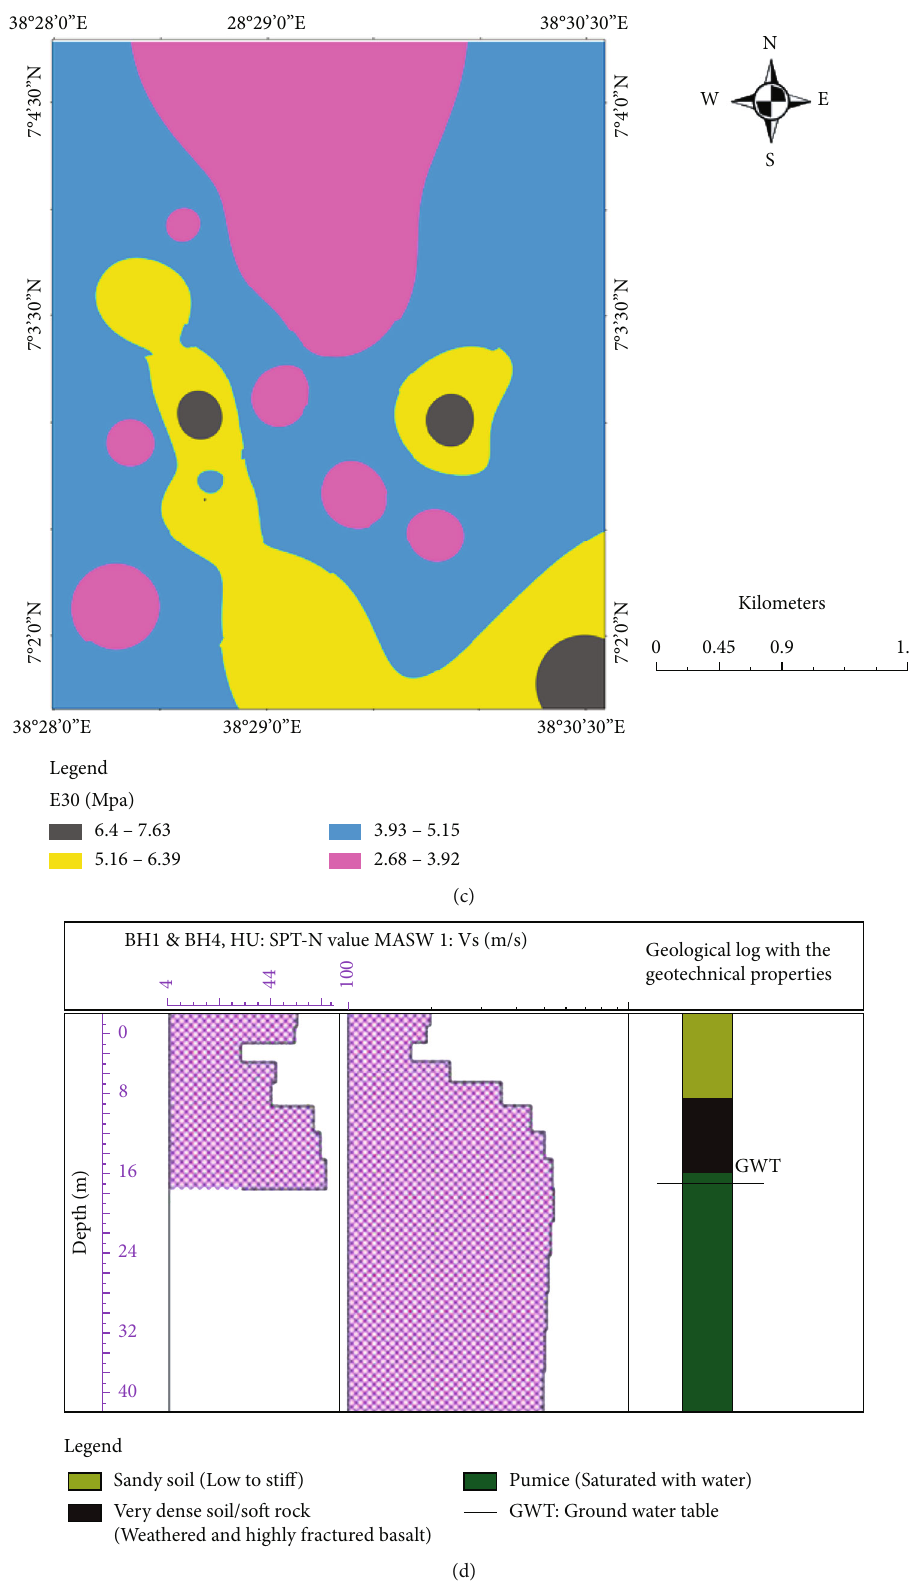
Figure 13: (a) Vs30 map of Hawassa town, (b) Gmax30 map of Hawassa town, (c) E30 map of Hawassa town, and (d) Lithological correlation between SPTN Values (BH1, BH4, and HU) with Vs for MASW